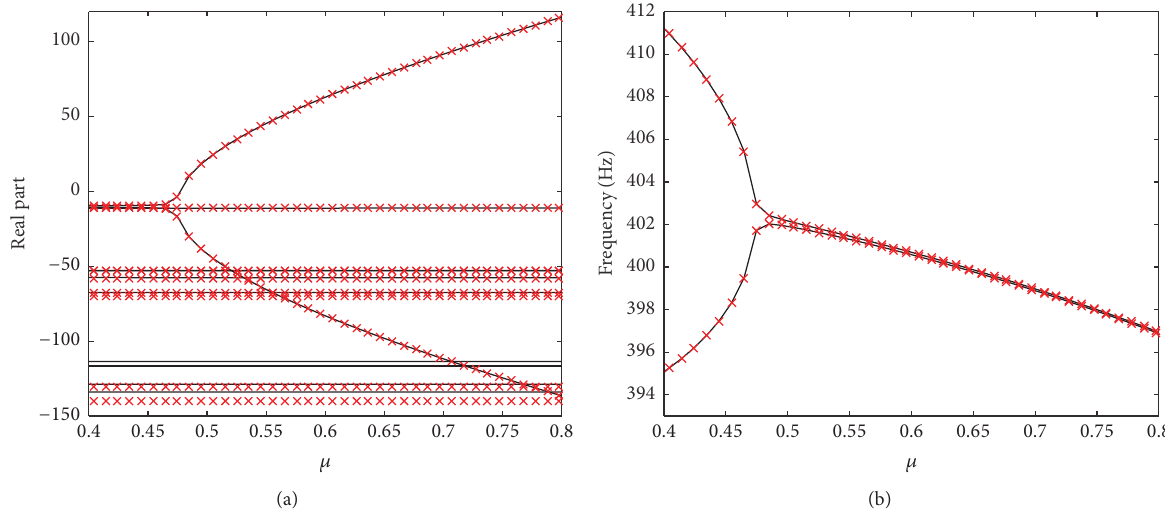
Figure 2: Stability analysis based on the reduced model (red marks) and the reference model (black lines). (a) Real parts. (b) Imaginary